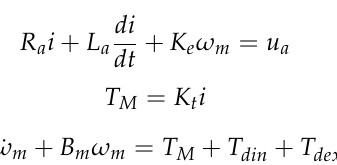
Figure 1. Schematic diagram of an inertial stabilization imaging sensor (ISIS)